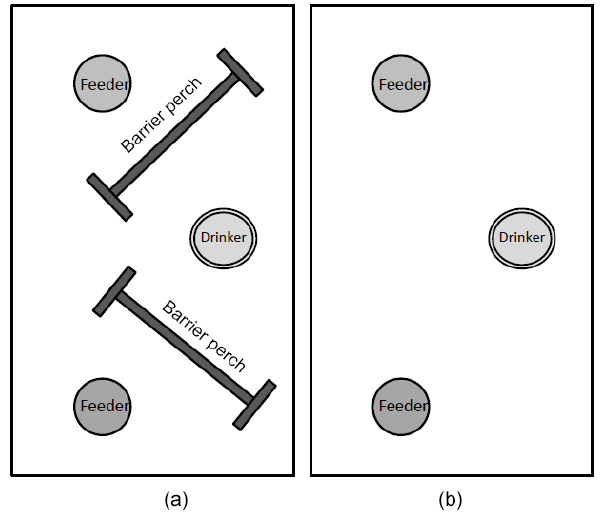
Figure 1. Design of the perch and layout of the experimental pens (a) with barrier perches (perch group) and (b) without barrier perch (control